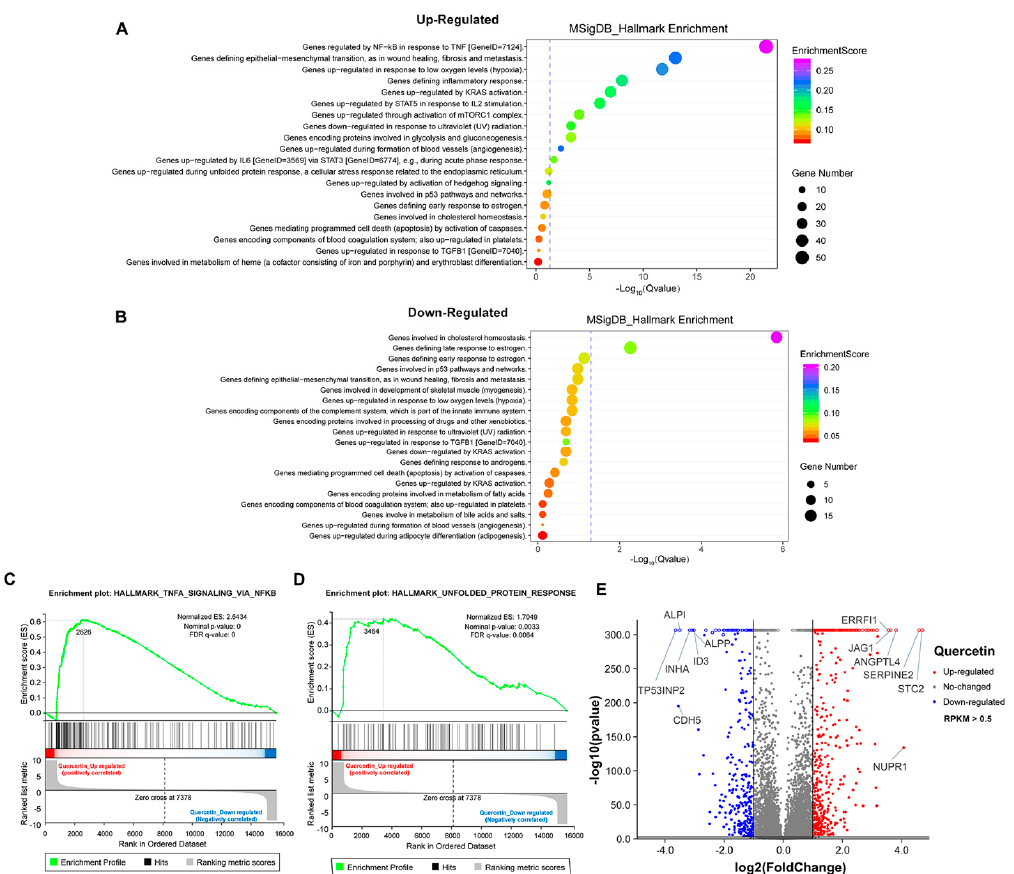
Figure 6. Transcriptome analysis of MCF–7 cells treated with high dose of flavonoids. ( A ) The heat map of cells treated with DMSO or 50 µM apigenin/quercetin for 48 h. ( B ) The GO analysis of cells treated with 50 µM apigenin for 48 h (upregulated). ( C ) The GO analysis of cells treated with 50 µM apigenin for 48 h (downregulated). ( D ) The GSEA analysis of cells treated with 50 µM apigenin for 48 h. TNF- α signaling was enriched and upregulated. ( E ) The GSEA analysis of cells treated with 50 µM apigenin for 48 h. Unfolded protein response signaling was enriched and upregulated. ( F ) The volcano plot revealing the most differentially expressed genes of cells treated with 50 µM apigenin for 48 h. The selection of differentially expressed genes from the transcriptome was based on log 2 |fold change| > 1, p value < 0.01.